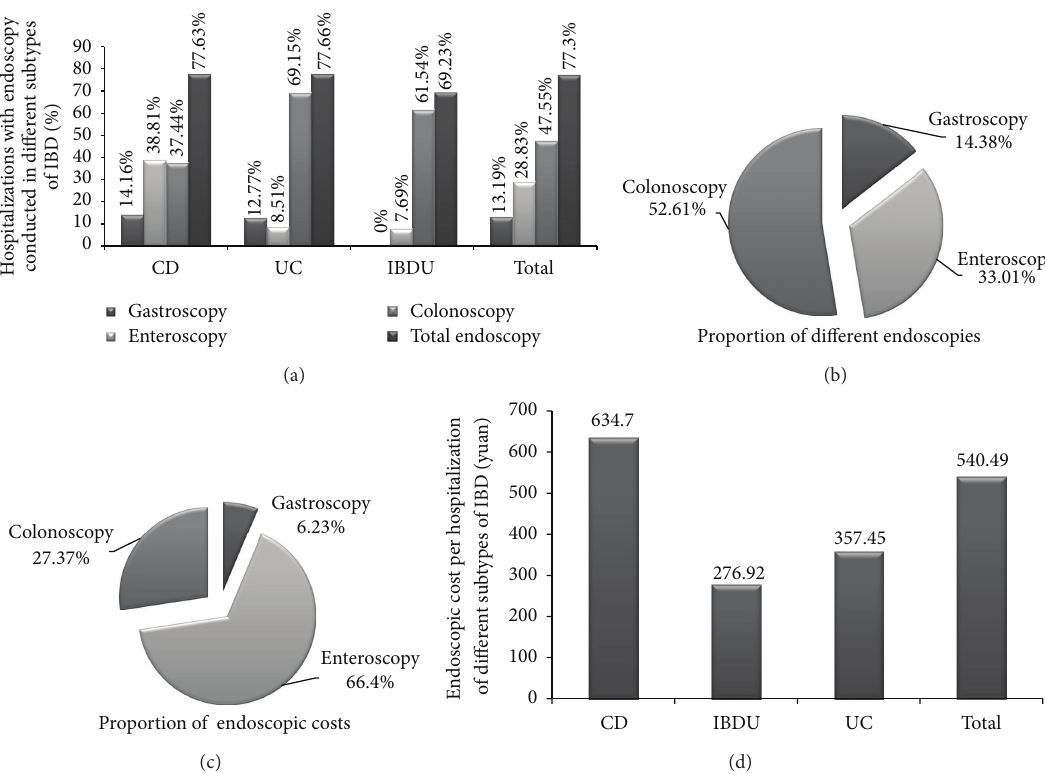
Figure 6: Endoscopies used in IBD determination or evaluation. (a) Percentage of hospitalizations with endoscopy conducted in different subtypes of IBD; (b) the proportion of different endoscopies; (c) the proportion of endoscopic costs; (d) endoscopic costs per hospitalization of different subtypes of